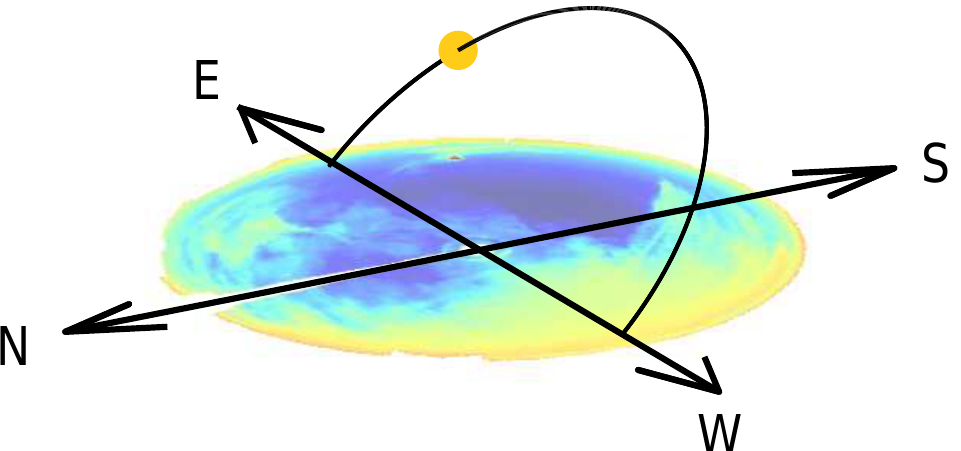
Figure 4. Cardinal coordinates of each image with sun trajectory: it rises to the left, reaches the noon on the top and sets to the right of 2D